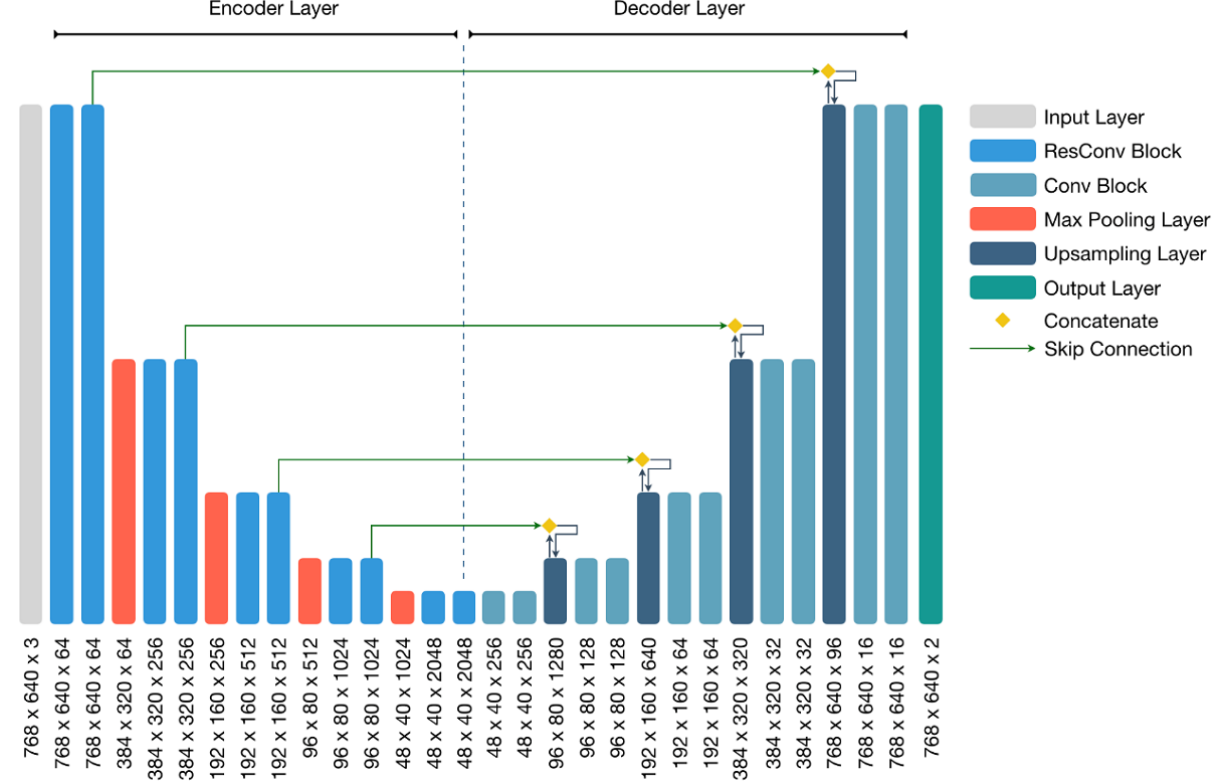
Figure 2. The pneumonia segmentation model based on U-Net. ResNet-50 was used as the encoder backbone model. The squeeze-and-excitation block was added to each ResConv block to enhance feature extraction from feature maps. The skip connection was used to concatenate the encoder feature map with the decoder feature map after upsampling. Conv: convolutional; ResConv: residual